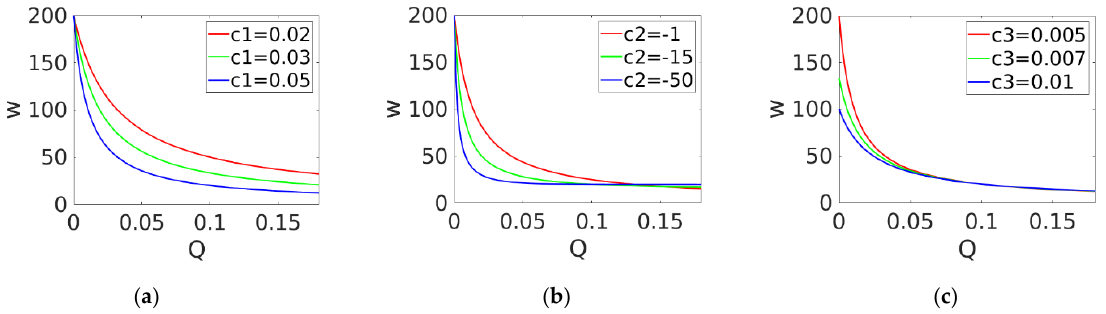
Figure 5. Illustration of the impacts of the control parameters 𝑐 1 , 𝑐 2 and 𝑐 3 on the weighting. Q (x-axis) represents the quality of the solution provided by scan-to-map registration derived from the average matching residual. The y-axis represents the weighting coefficient 𝑤 𝐿 . When one parameter changes, the other two remain constant. ( a–c ) are the illustrations of the weighting under different value of 𝑐 1 , 𝑐 2 and 𝑐 3 , respectively.